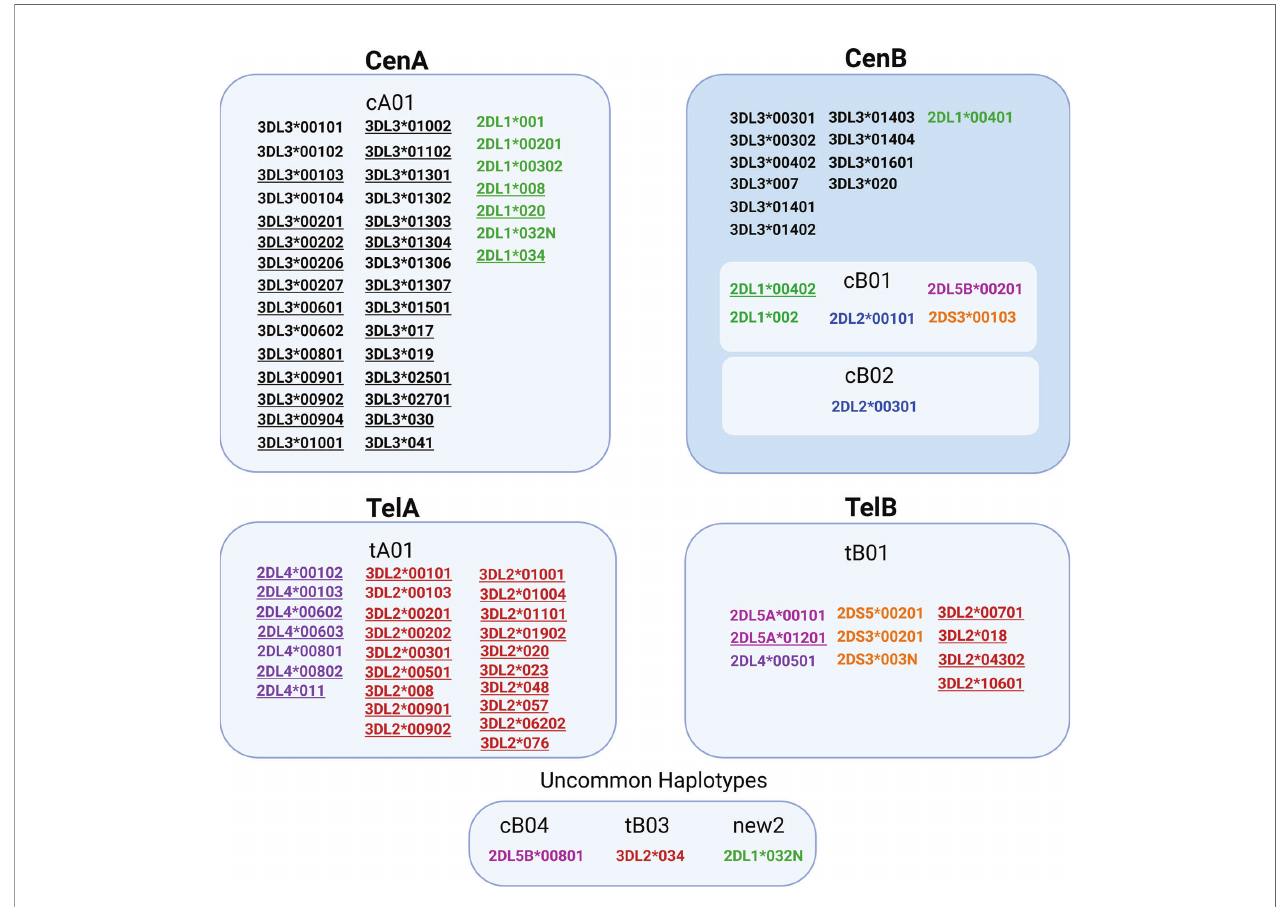
FIGURE 6 | Some alleles are associated with speci fi c KIR haplotypes. Alleles associated with speci fi c haplotypes are listed inside each box. Underline marks alleles exclusively present in the speci fi c haplotype. The other alleles were differentially associated with particular haplotypes, but not exclusively (>95% of the observations). For haplotype new2, please see Figure 2